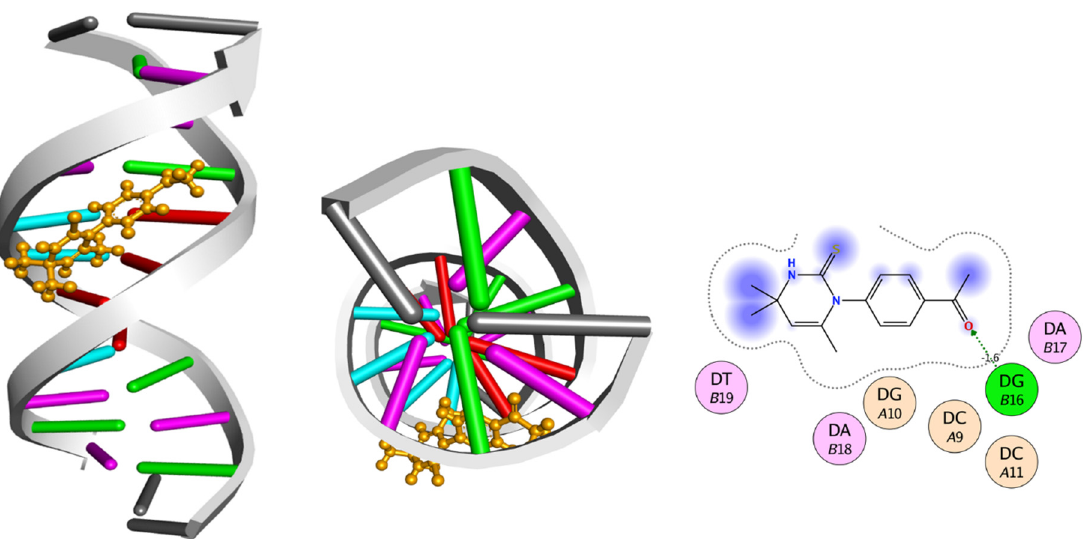
Figure 12. Docked conformation of compound 4 indicating DNA groove binding mode and 2D conformation.